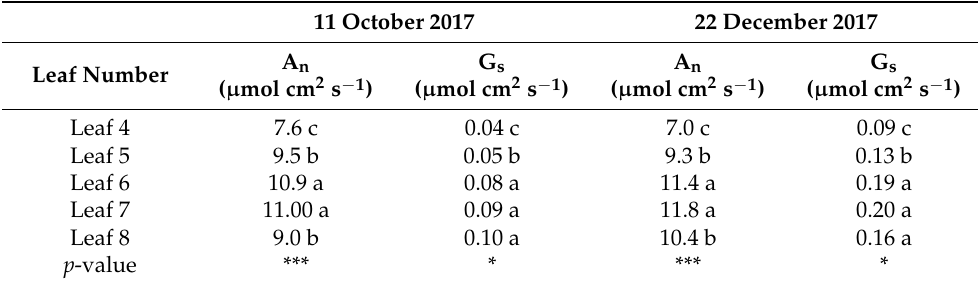
Table 2. Net photosynthesis (A n ) and stomatal conductance (G s ) for B. valdivianus during two evaluation dates at different leave ages.